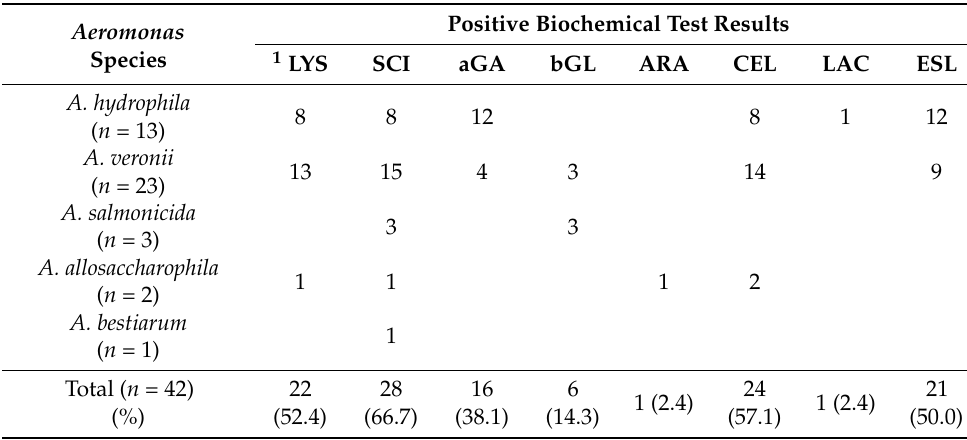
Table 2. Differences in the biochemical profiles of Aeromonas